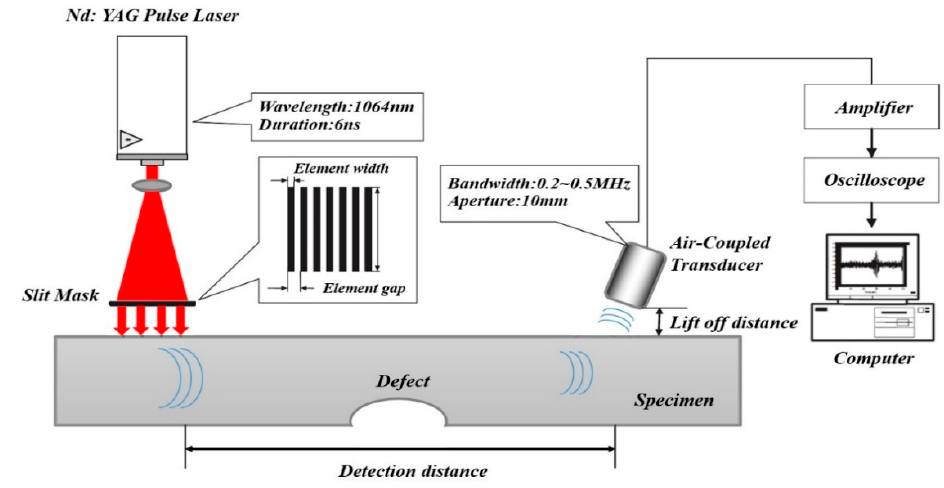
Figure 12. Schematic diagram of the experimental setup.